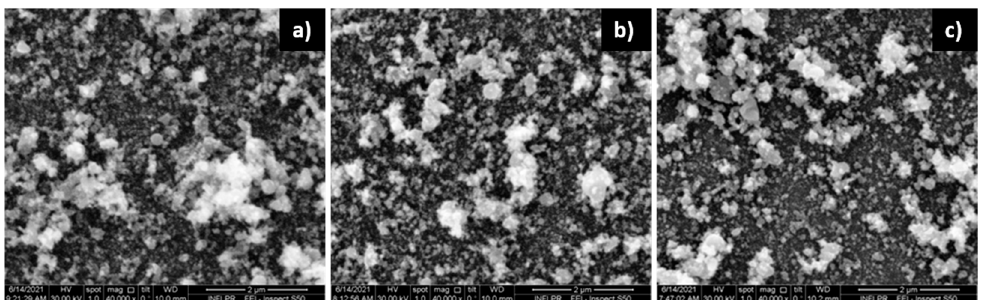
Figure 10. SEM images of ( a ) Pd/ZnO bilayer deposited in 2’23”/2 h with 10 kHz, using 0.2 W laser power at a wavelength of 1.06 µm. The Pd layer is deposited in 100 mTorr Ar, and the ZnO layer in 700 mTorr O 2 ; ( b ) same as ( a ), but the Pd layer deposited in 700 mTorr Ar; ( c ) ZnO layer only deposited in the same conditions as in ( a , b ).